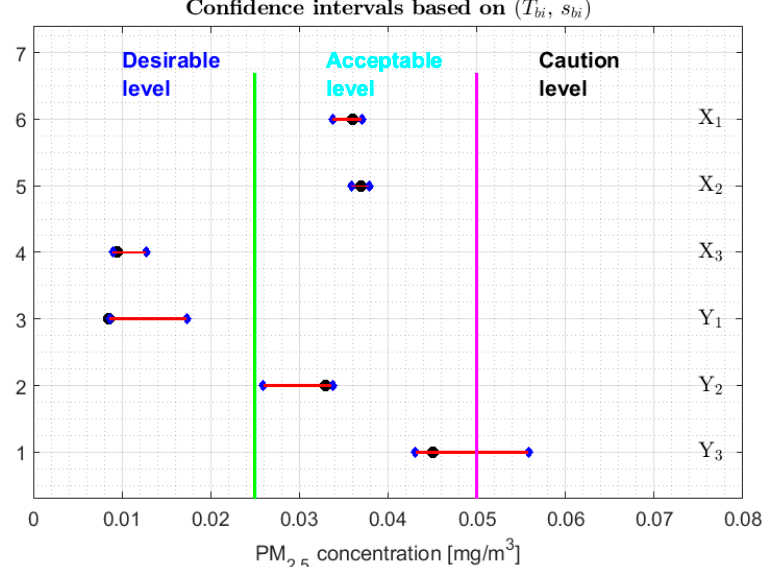
Figure 9. 95% confidence intervals based on ( T bi , s bi ) , and the bands that delimit the three lowest categories of air pollution by PM 2.5 concentrations in Quito. Median: Black circle; Ends of the intervals: Blue diamonds.